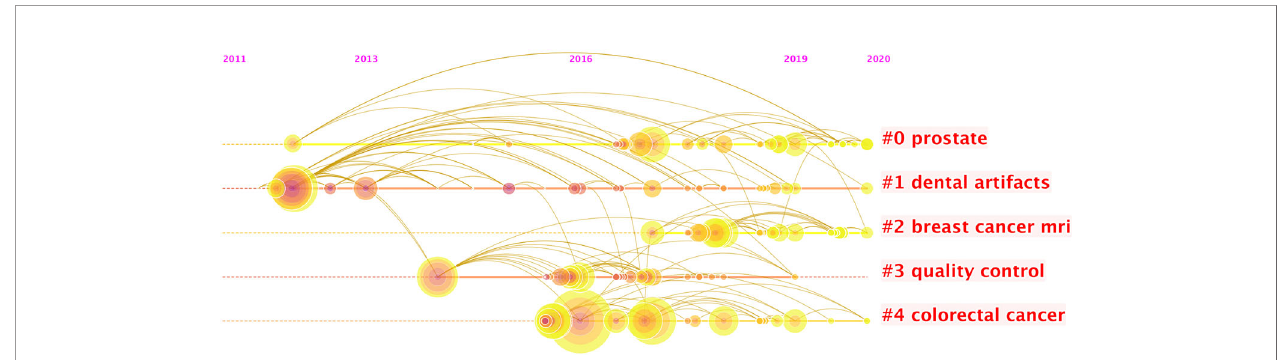
FIGURE 4 | The timeline view listed authors by clustering through keywords. Each node represents one author. The position of the node here represents the time of an author ’ s fi rst publication. There were 15 clusters of keywords. In each cluster, the size of each node shows the contribution of the author. It seems that the keywords “ prostate ” and “ breast cancer MRI ” occur most recently, which suggest the active participations of researchers in practicing radiomics for oncology related to them, and it also shows that researchers have been practicing radiomics research related to dental artifacts since it lasts the longest